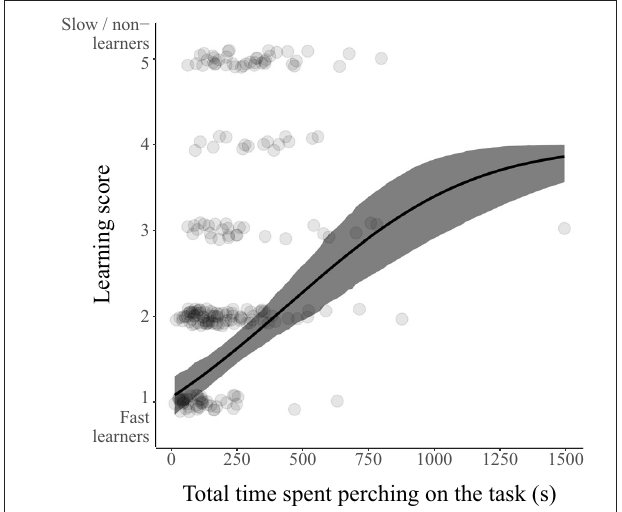
FIGURE 3 | Relation between the total time spent perching on the task before the first entrance and learning score. Low score values indicate fast learning individuals, and high score values slow or non-learning individuals (i.e., learning score increases with decreasing learning performance). Predicted distributions (means and 95% CI) are estimated for the sake of illustration from a model including only time spent perching on the task as a fixed effect. Data points are shown in